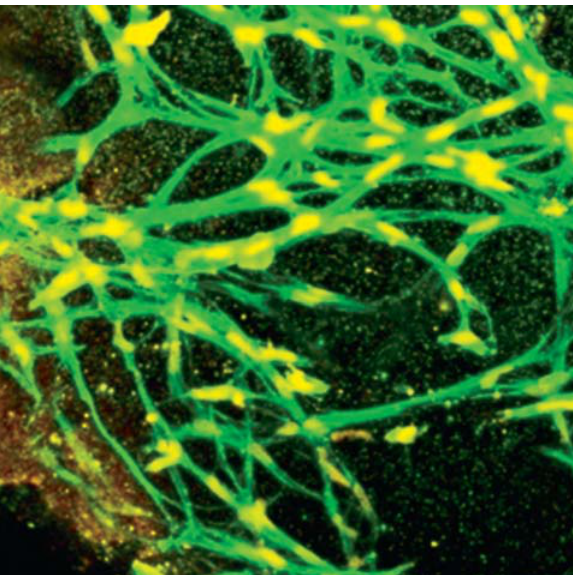
Figure 6- Dermal-epidermal skin substitute, immunostained, showing cell distribution. Red (Sytox, Invitrogen), green (Phalloidin,